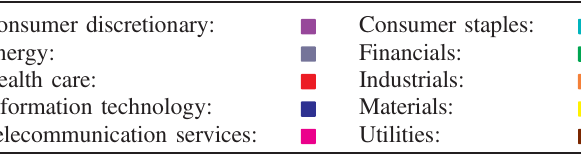
TABLE I. The 10 industry sectors in the Global Industry Classification Standard (GICS), with the color representation used to highlight the sectors in the following